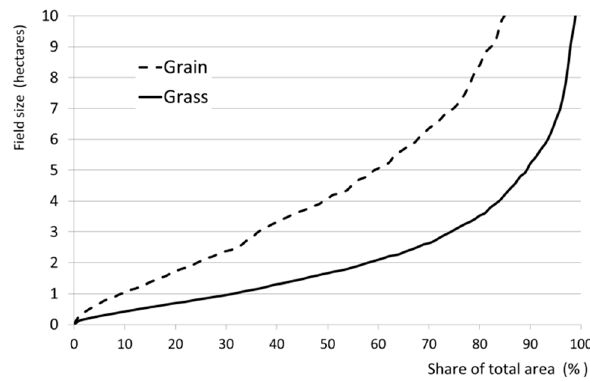
Figure 4. The distribution of the total area of grain crops and grass crops according to field size, illustrating that most of the grain and grass area in Norway is in small fields.